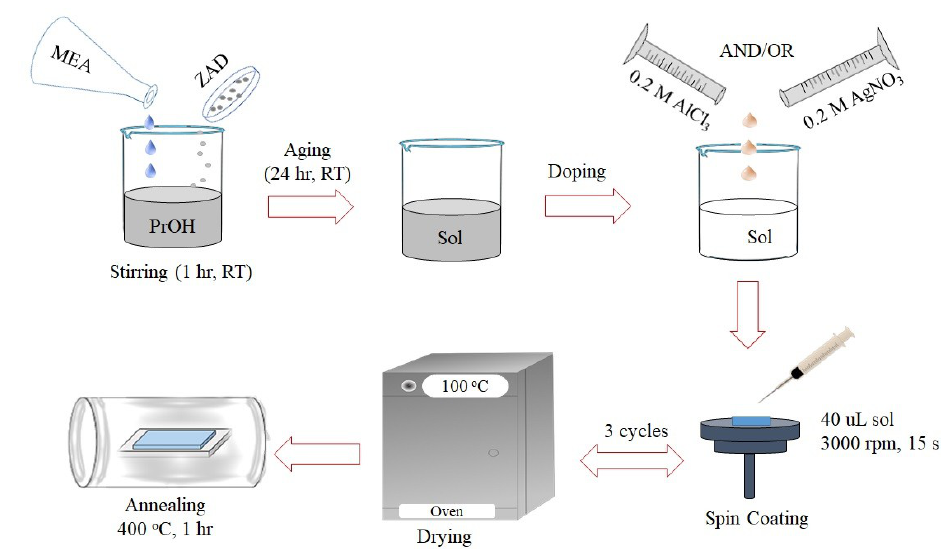
Figure 1. Schematic diagram showing different stages of intrinsic and doped ZnO films synthesis.